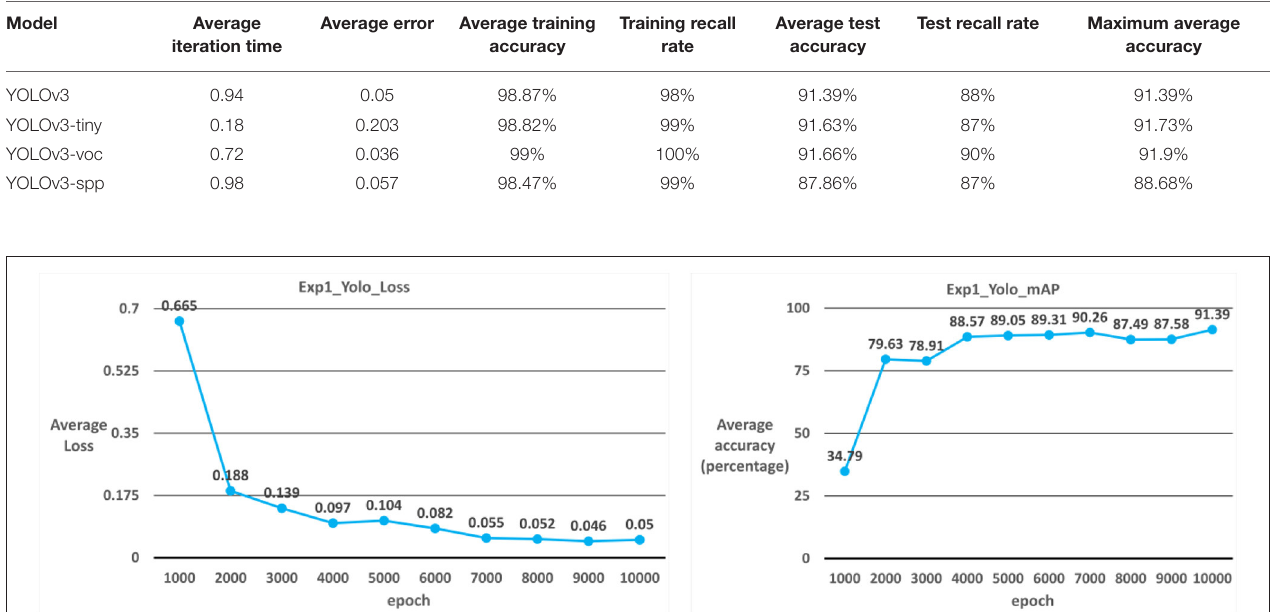
TABLE 2 | Experiment 1-various YOLO models result comparison table.